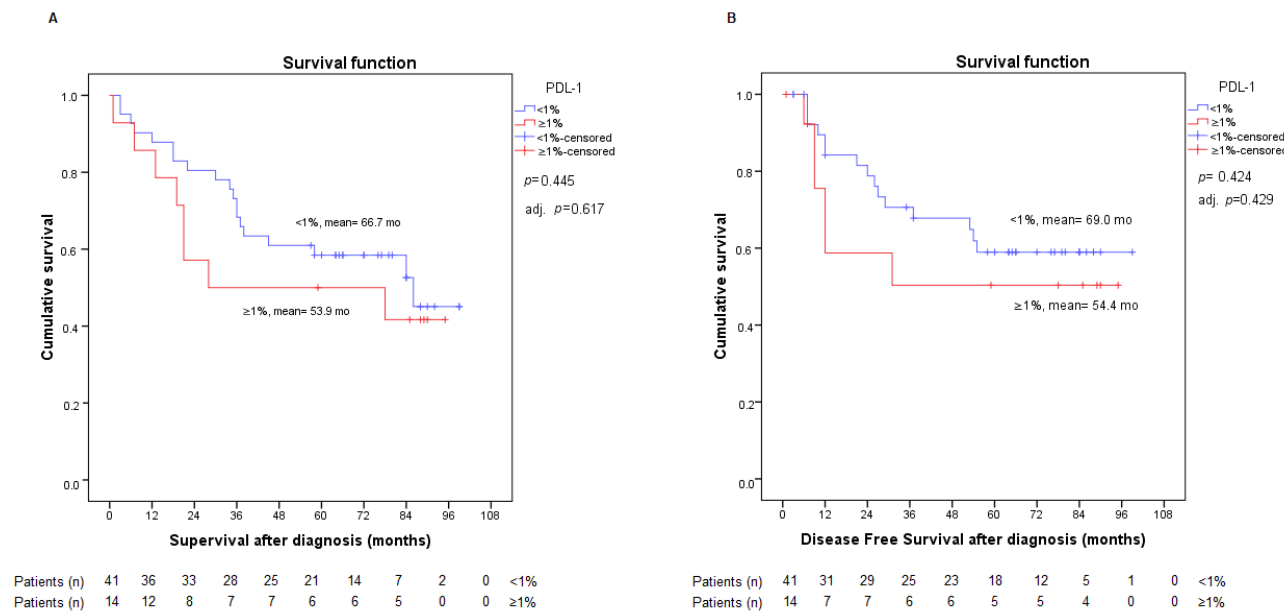
Figure 1. Histological algorithm of evaluation (as described in Sections 4.2–4.4 of Section 4) and frequency distribution for the biomarkers of interest. The six-pointed stars show intraepithelial lym- phocytes. All images at 20× magnification (digital zoom) except for TGF- β nuclear staining (40×).